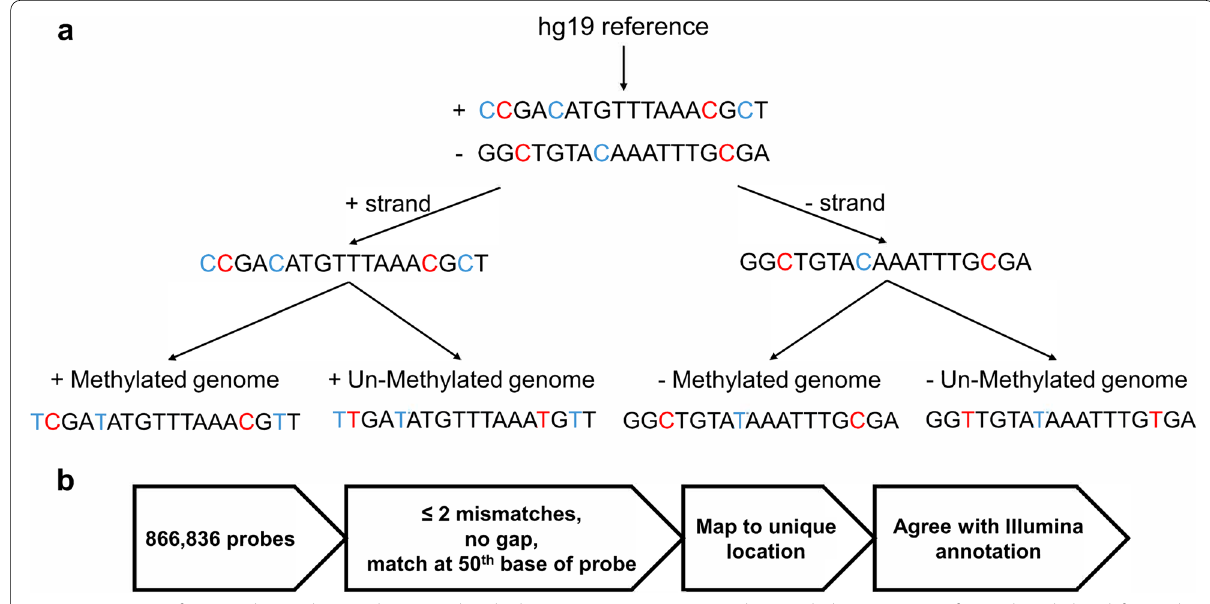
Fig. 1 Detection of CpG probes ambiguously mapped to the human genome. a Four single-stranded genomes (i.e., forward methylated, forward unmethylated, reverse methylated, and reverse unmethylated) were generated in silico bisulfite conversion (blue represents Cs of non-CpG; red represents Cs of CpG sites). b Matching criteria for detection of ambiguous